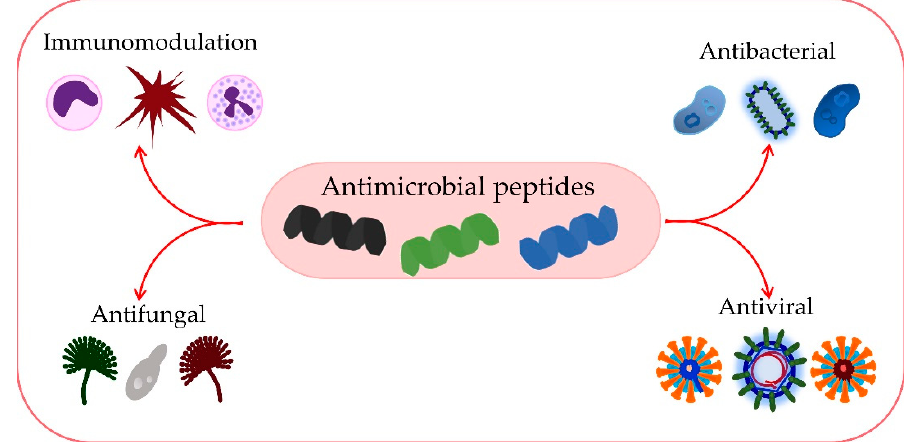
Figure 6. Numerous functions of